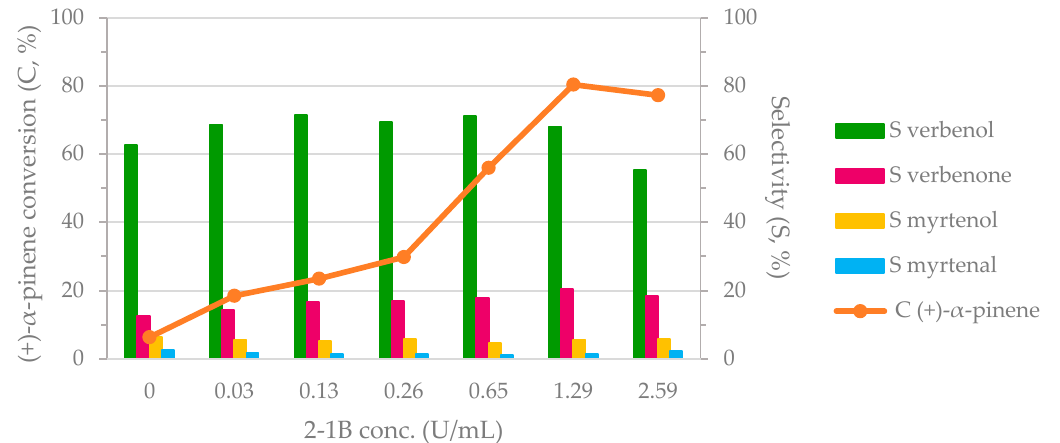
Figure 1. The influence of 2-1B peroxidase on the biocatalytic cascade system. Reaction conditions: 0.63 M (+)- α -pinene, 1.28 M H 2 O 2 , 216 POU/mL M120 laccase, and 2-1B peroxidase in acetate buffer (0.1 M, pH = 5) for 24 h at 40 °C and 1000 rpm stirring rate.